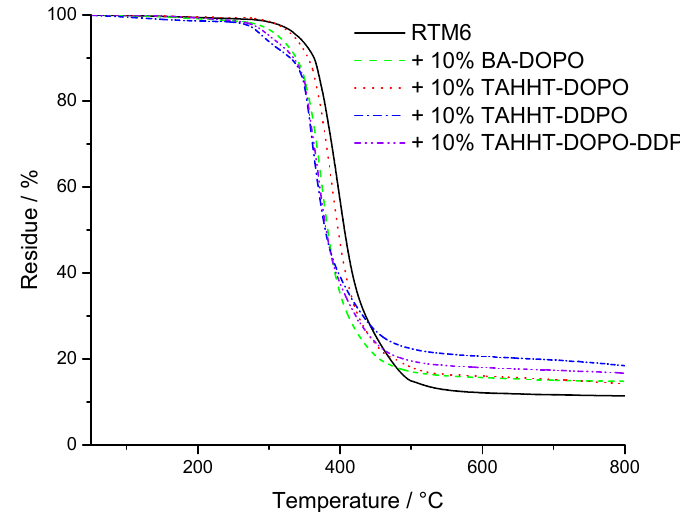
Figure 4. TG-curves of RTM6 and flame-retarded samples measured under N 2 -atmosphere.